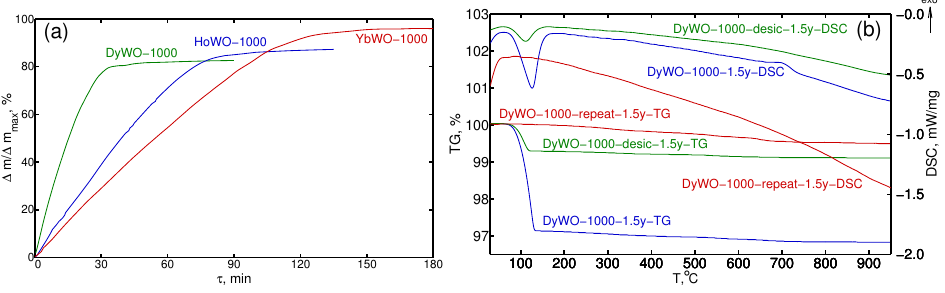
Figure 2. Hydration kinetics for Ln WO-1000 ( a ) and STA curves for differently treated Dy tungstate samples ( b ): (1) DyWO-1000-1.5y; (2) DyWO-1000-desic-1.5y; (3)